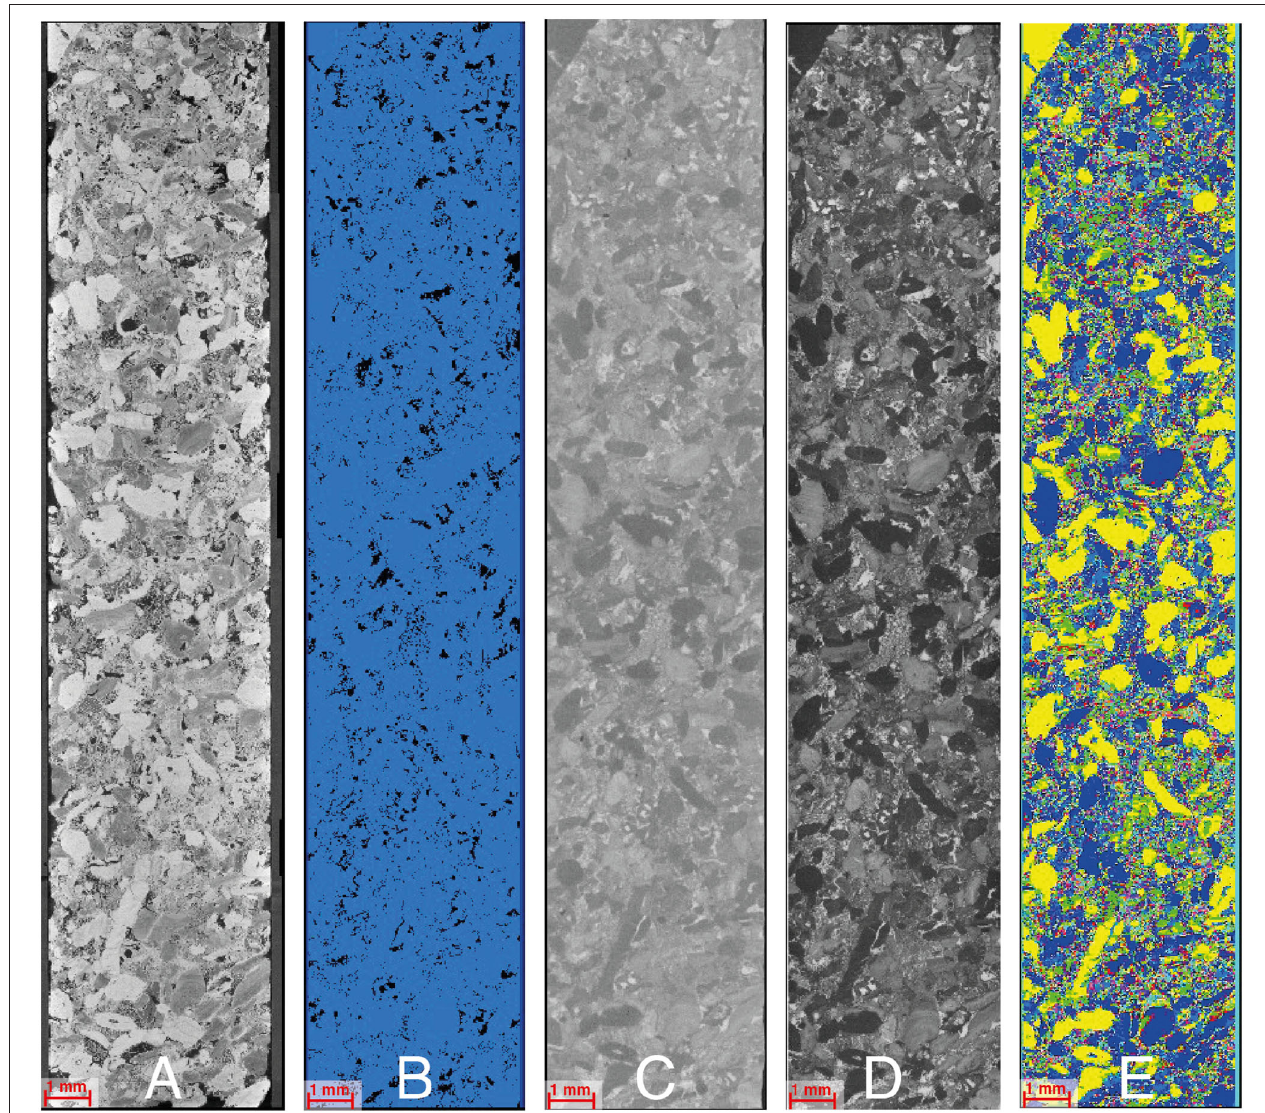
FIGURE 10 | The image processing workflow. The dry scan (A) is segmented using machine learning (B) . The doped scan (C) is subtracted from the dry scan to get the difference image (D) . The difference image greyscale is then thresholded to 12 different porosity values and grains, and then the pore space of segmented dry scan (B) is masked to create the 14-phase segmentation of solid grains (yellow), 12 types of microporous grains (randomly colored), and pores (light blue) (E) .